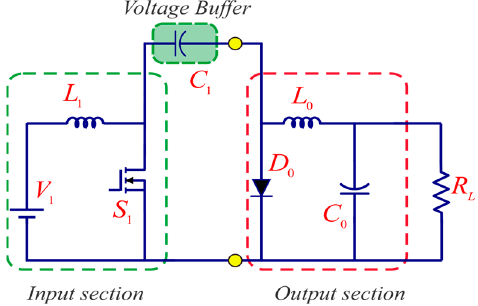
Figure 2. Structure of classical Cuk converter.